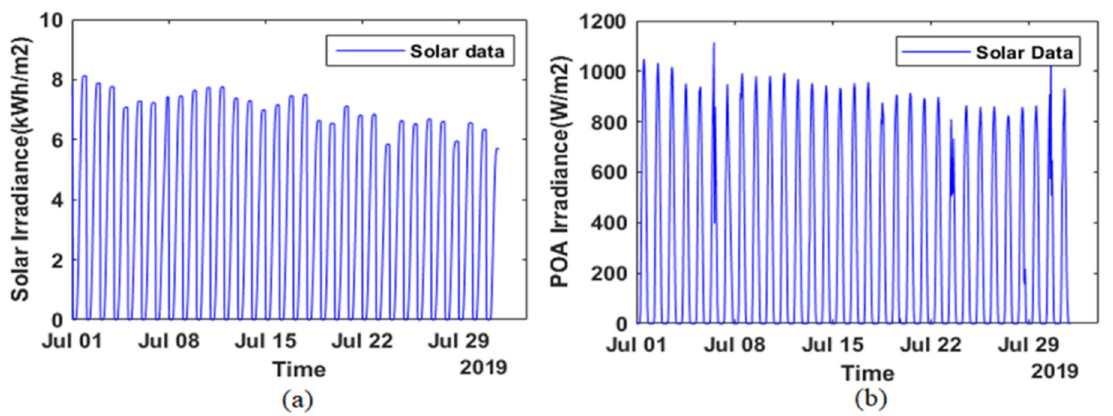
Figure 2. Distribution of solar irradiance: ( a ) Solar Irradiance; ( b ) POA Sweihan Photovoltaic Independent Power Project.